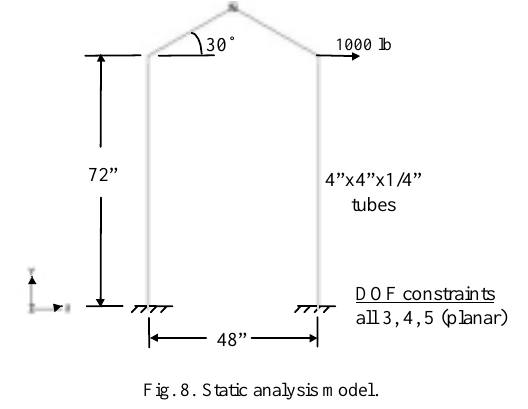
Fig. 8. Static analysis